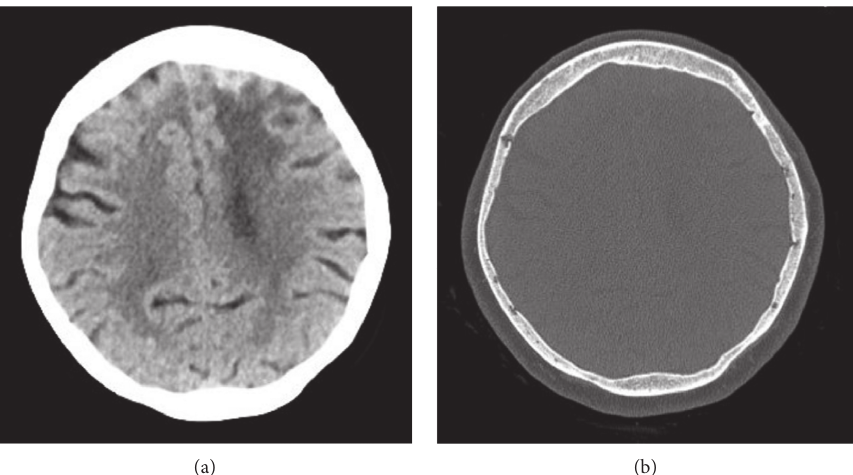
Figure 1: CT head: (a) left frontal extra-axial lesion with patchy calcification and vasogenic oedema; (b) CT bone window setting showing osteopenia but no bony erosion or hyperostosis.